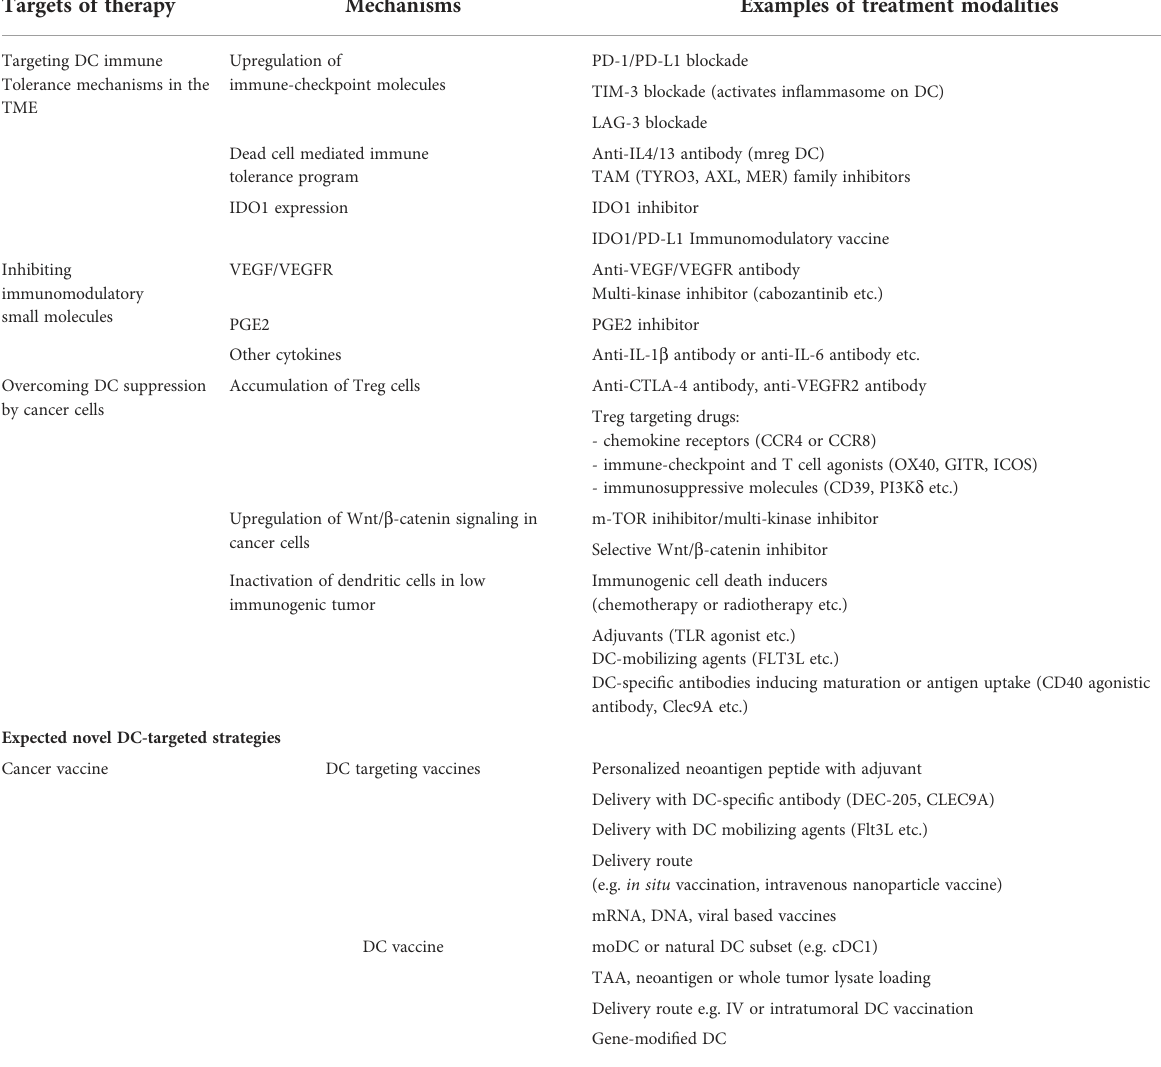
TABLE 1 Overcoming strategies to tackle DC impairments in the